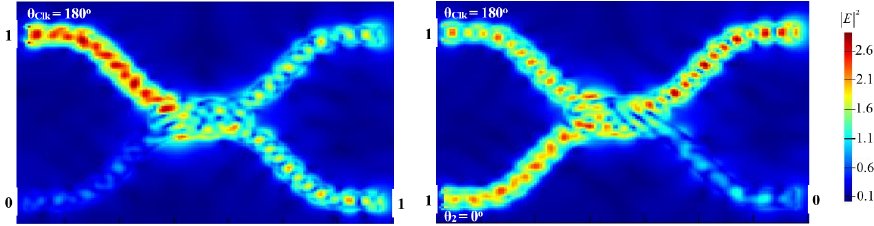
Figure 11. Light field distributions for NOT function utilizing 2 × 2 silicon waveguide at 1.55 μ m.